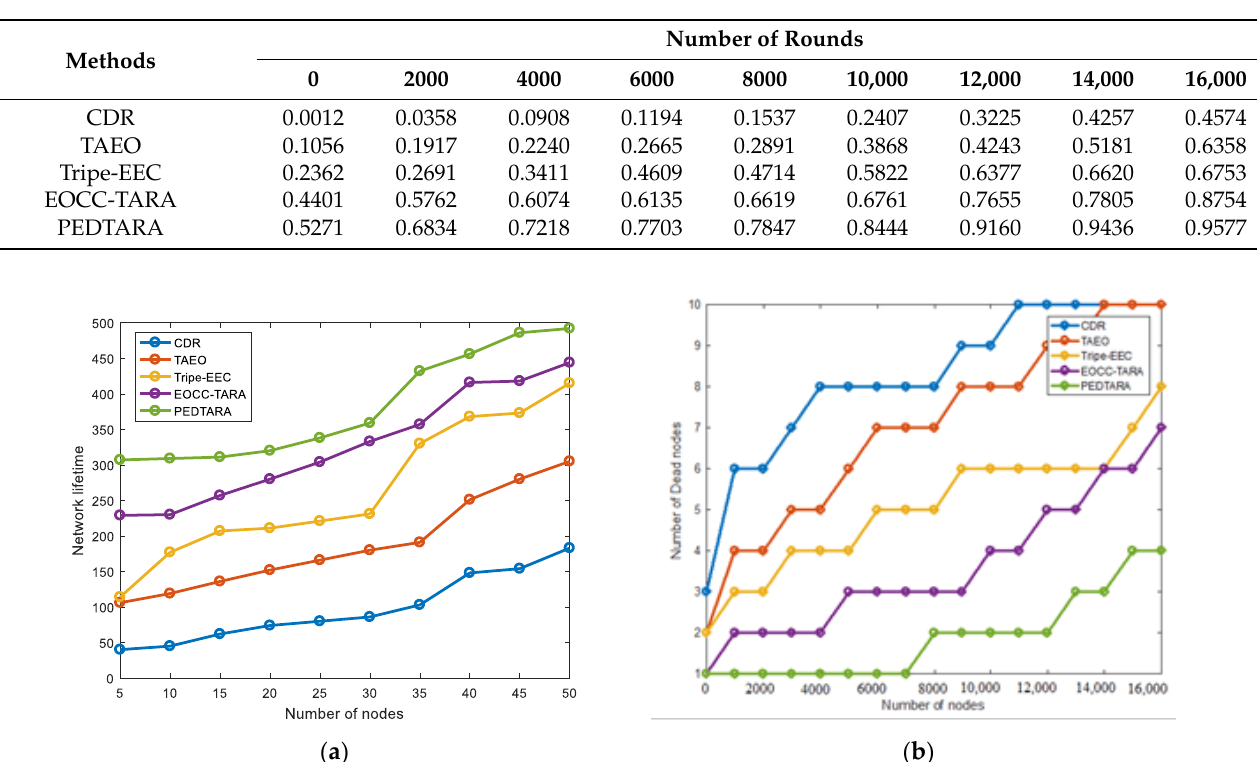
Figure 9. Comparison of network lifetime and number of dead nodes: ( a ) network lifetime; ( b ) number of dead nodes.